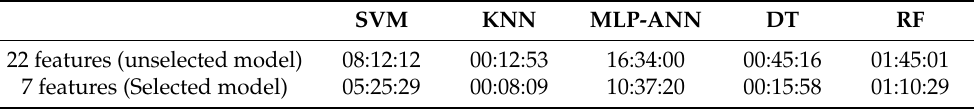
Table 3. Time performances of each ML algorithm. SVM, Support vector machine; RF, Random Forest; DT, Decision tree; KNN, K-Nearest-Neighbor; MLP-ANN, Multilayer Perceptron—Artificial neural network. SVM KNN MLP-ANN DT RF 22 features (unselected model) 7 features (Selected